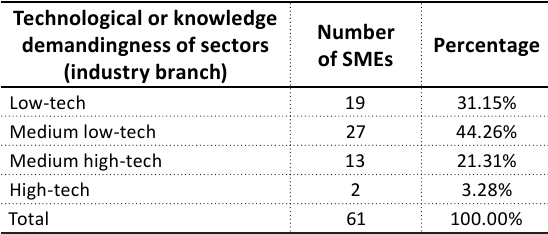
Table 2. Affiliation of SMEs funded by venture capital to industry branch in compliance with in conditions of the Slovak Republic Source: Own